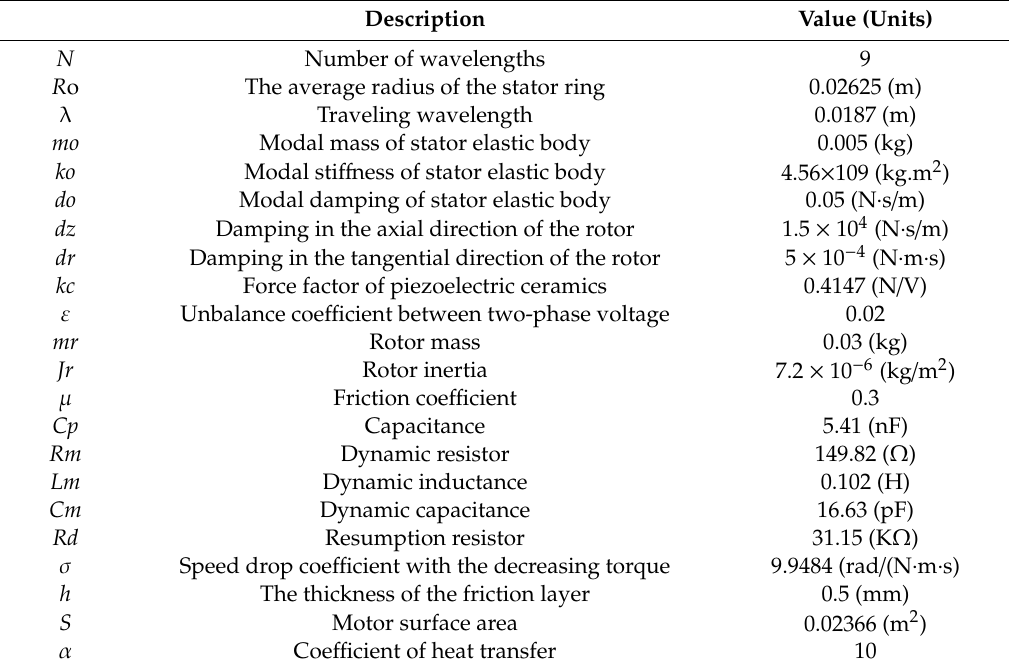
Table A1. The TRUM60A simulation